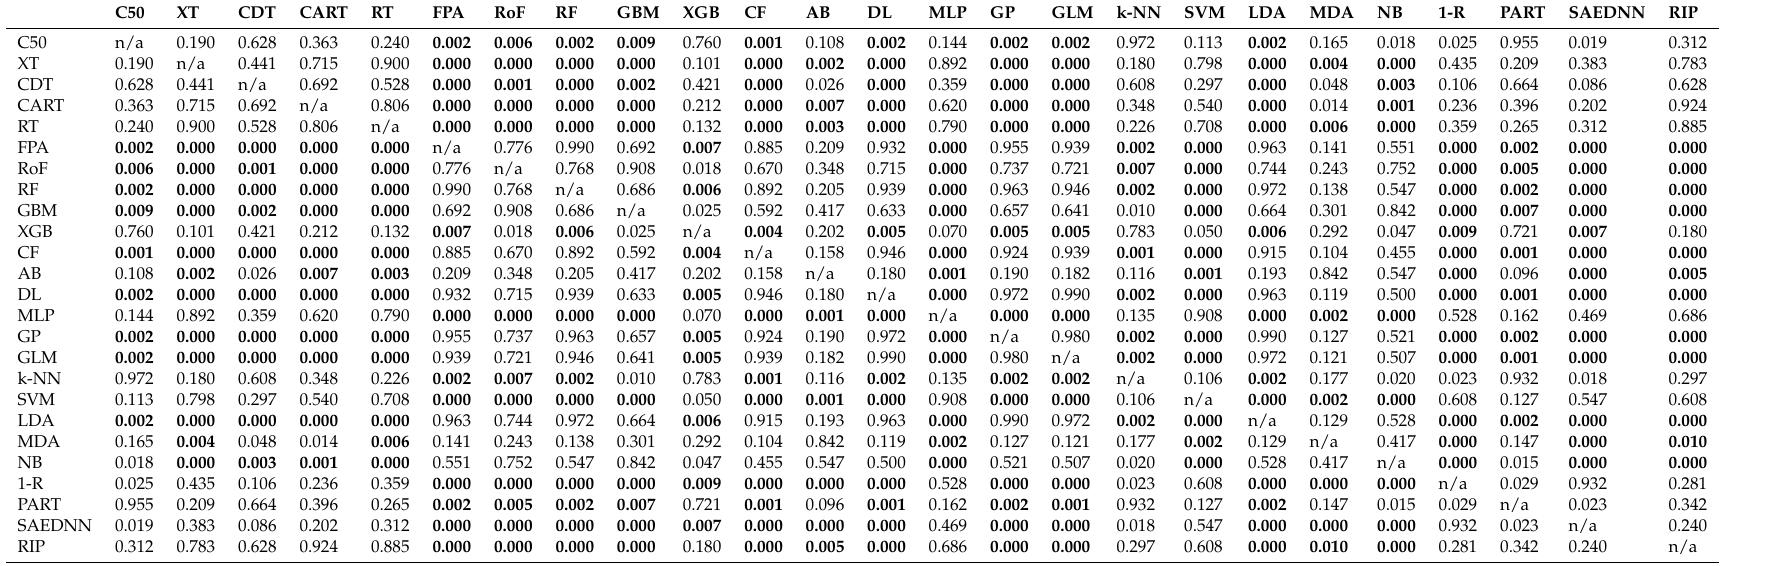
Table 3. Results of a post-hoc test using Finner correction w.r.t 10ho (bold indicates significance at p -value <